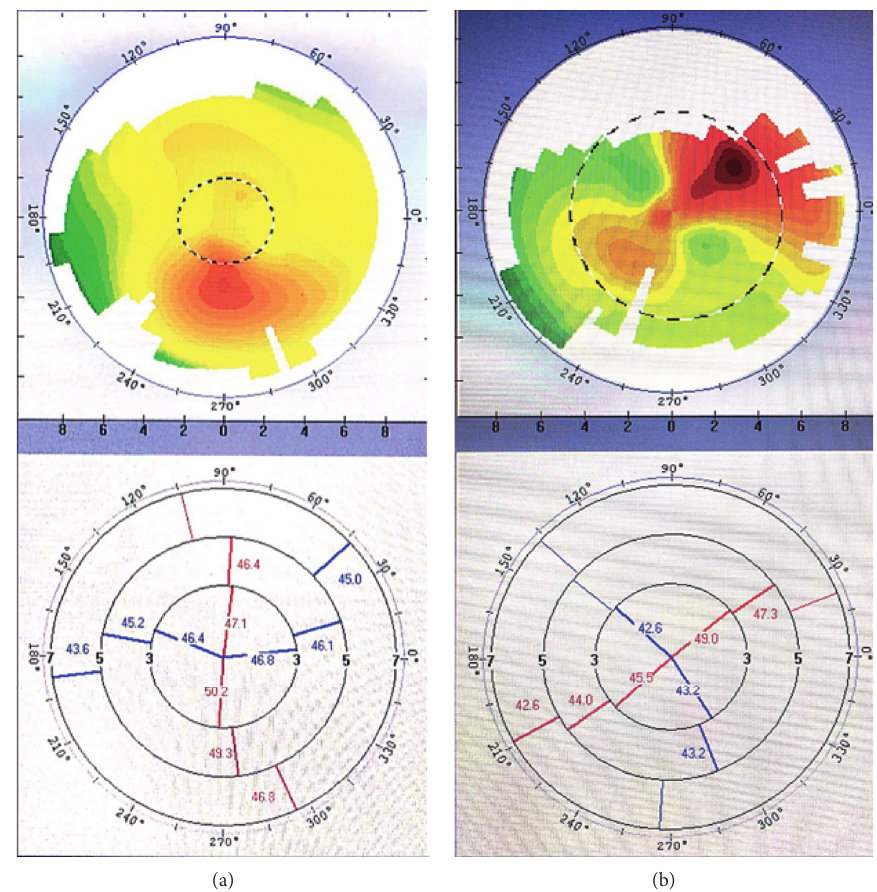
Figure 1: Corneal topography showing a cornea with a hemimeridional pattern. (a, b) The difference in K value in the central 3-mm zone between the two hemimeridional lines (in red) was > 3D in each